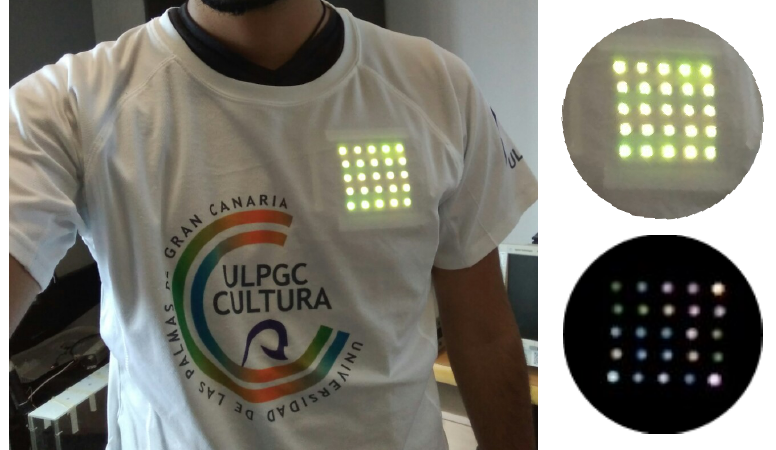
Figure 3. Transmitter